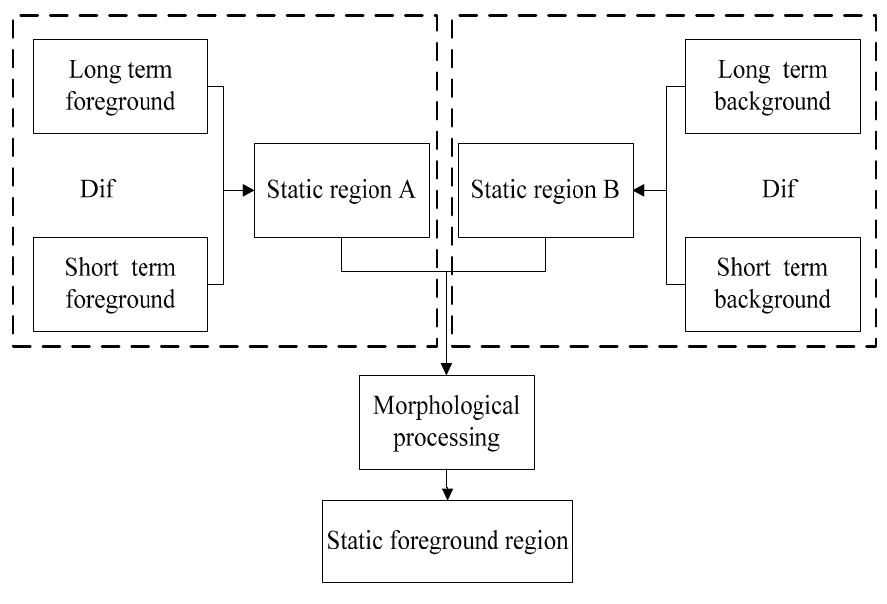
Figure 7. Static foreground region